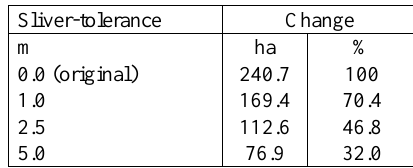
Table 3. Effect of sliver polygons in one heavily affected municipality (2012 to